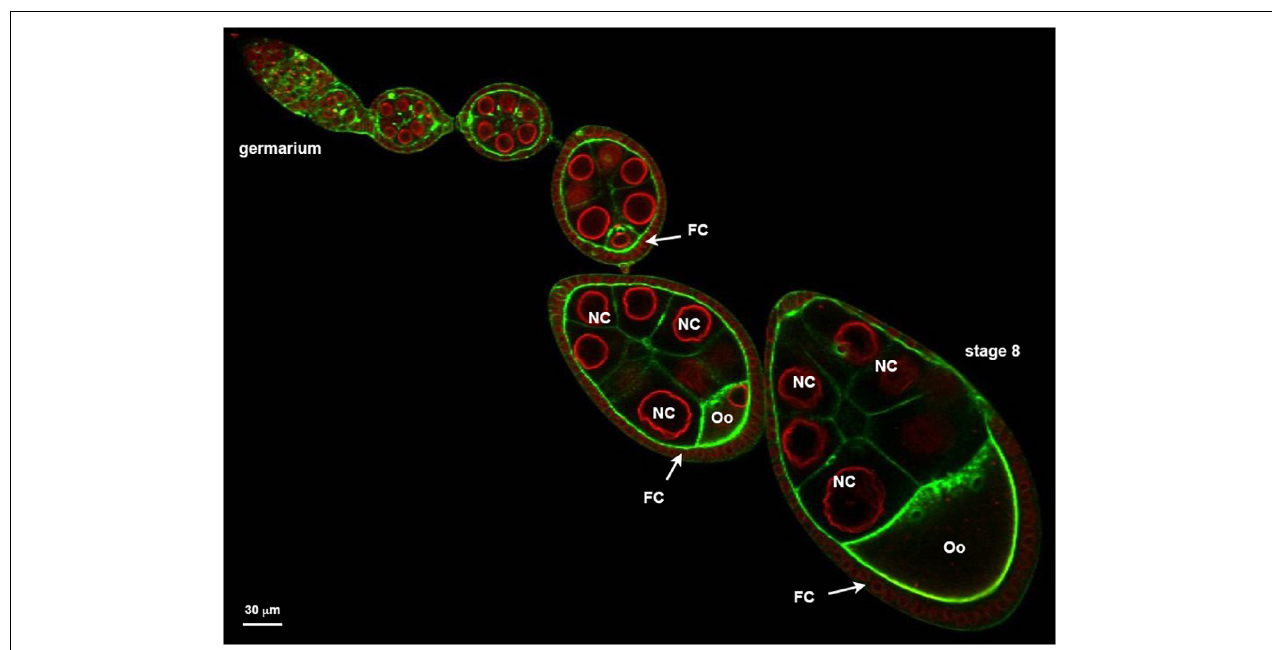
FIGURE 1 | Ovariole organized in a succession of developing follicle. Nuclear envelopes (red) are stained with alexa594-WGA and the cortical actin (green) revealed with Alexa448-Phalloïdin. Follicles are developmental subunits in which the oocyte (Oo) develops. The oocyte is located at the posterior of the follicle and is associated with 15 additional germ cells named nurse cells (NC). A monolayer of follicular cells (FC) surrounds the germline. On the example presented here, the ovariole exhibits at its anterior extremity (left) a region called germarium in which the stem cells proliferate. At the other extremity (right) a stage 8 showing an oocyte that represents almost one half of the